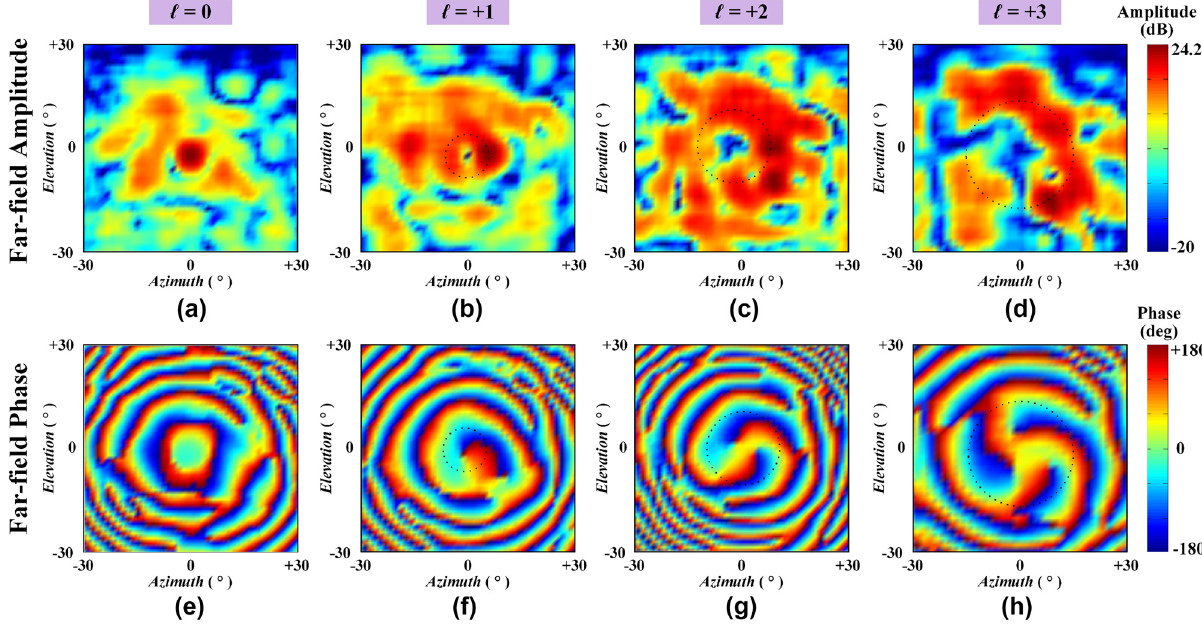
Figure 7: Far-field experimental results of the fabricated metasurface for different OAM modes. Amplitude: (a) l = 0, (b) l = + 1, (c) l = + 2, (d) l = + 3. Phase: (e) l = 0, (f) l = + 1, (g) l = + 2, (h) l = + 3.